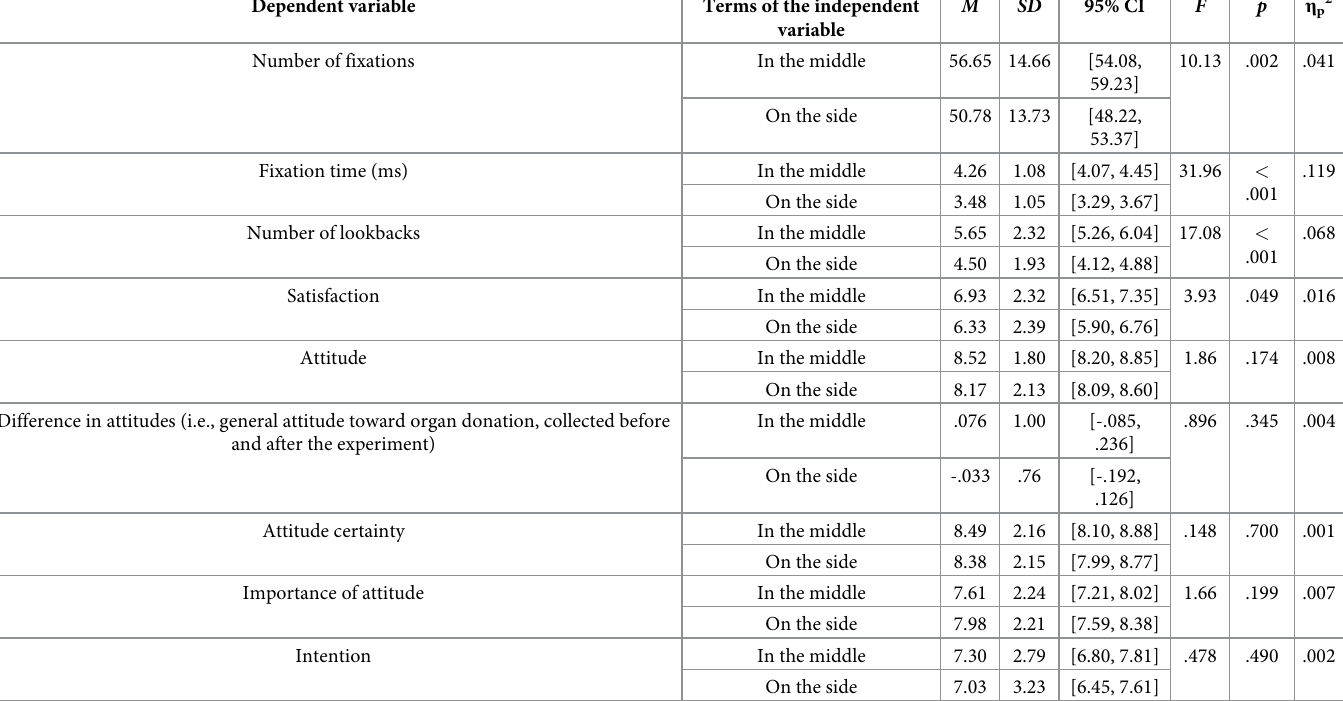
Table 3. Effects of location of the persuasive argument on the screen (summary of ANOVA results).